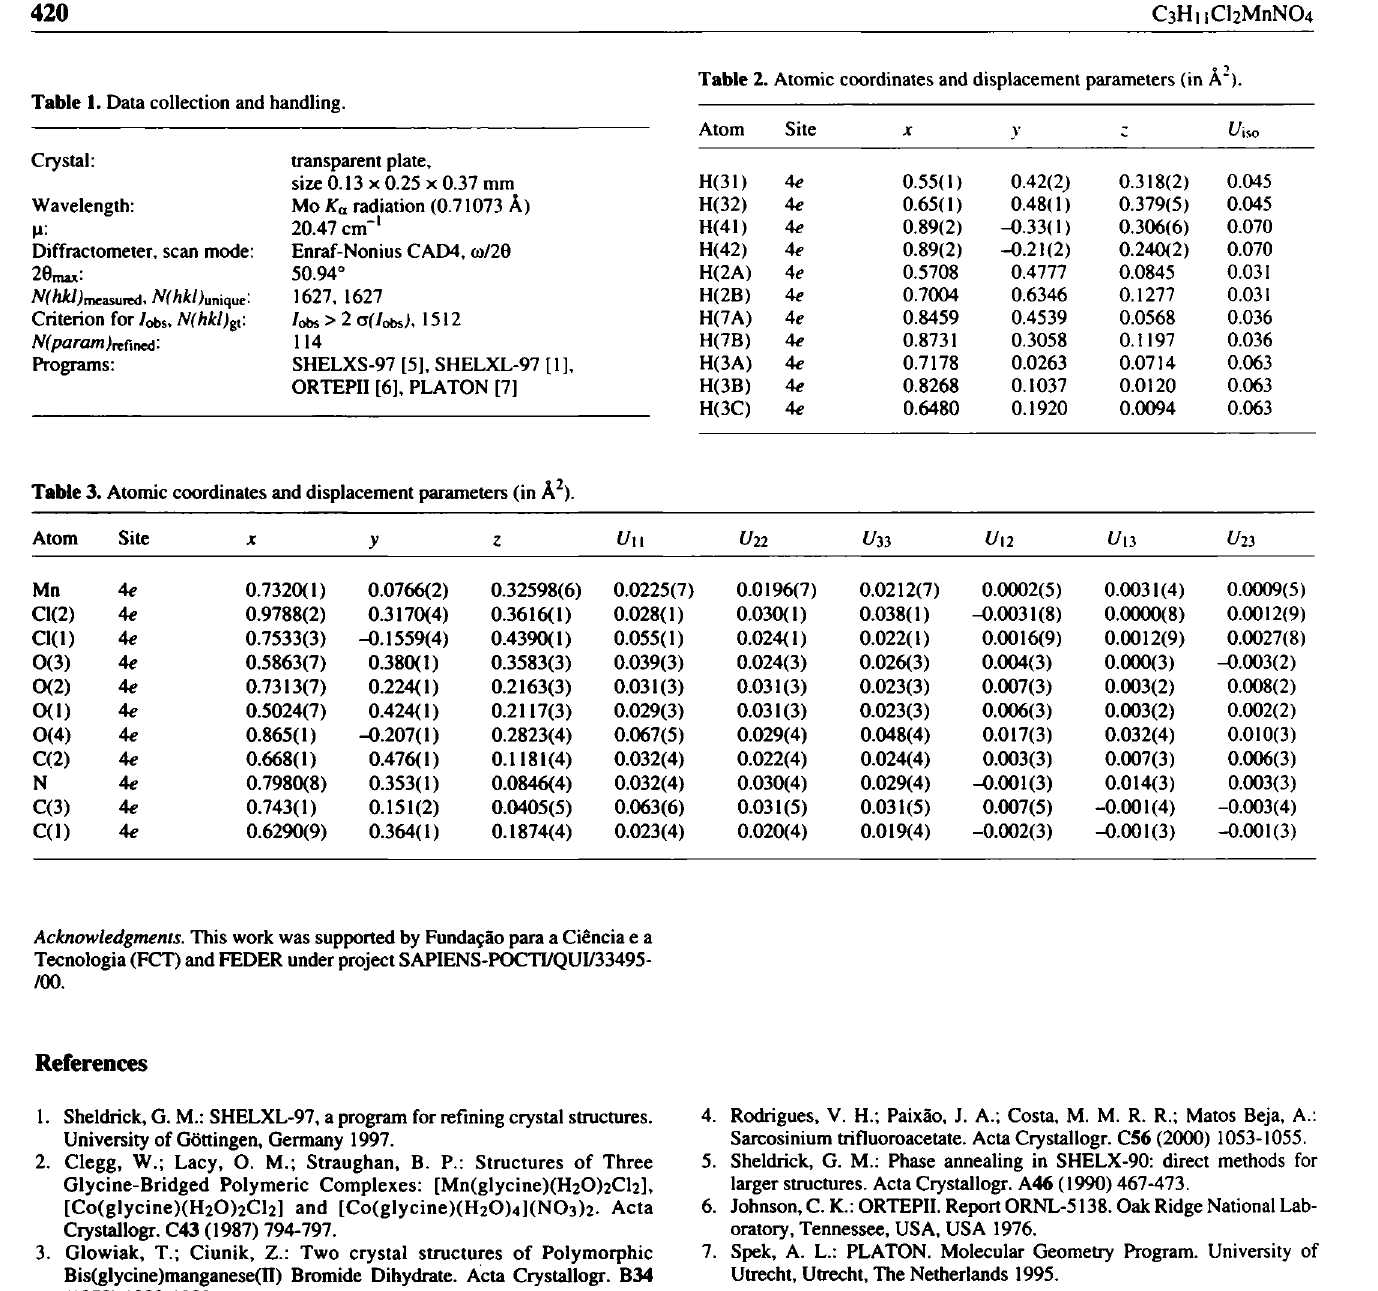
Table 2. Atomic coordinates and displacement parameters (in k 2 ).